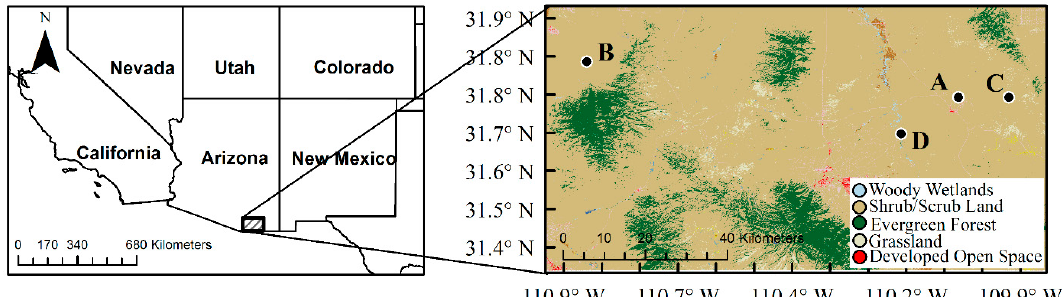
Figure 1. Figure 1. Region of interest in southern Arizona with flux tower site locations: (A) Lucky Hills (US-Whs); (B) Santa Rita–Mesquite (US-SRM); (C) Kendall Grassland (US-Wkg); and (D) Charleston–Mesquite (US-CMW), and vegetation characteristics derived from the National Land Cover Database [40].